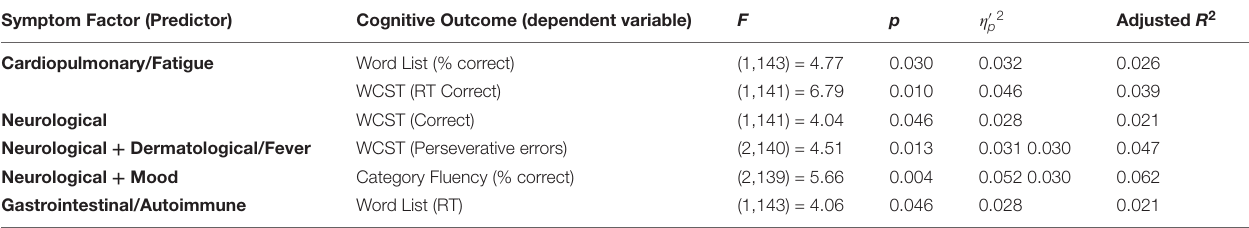
TABLE 5 | Ongoing symptom factors and subsequent cognitive performance. Symptom Factor